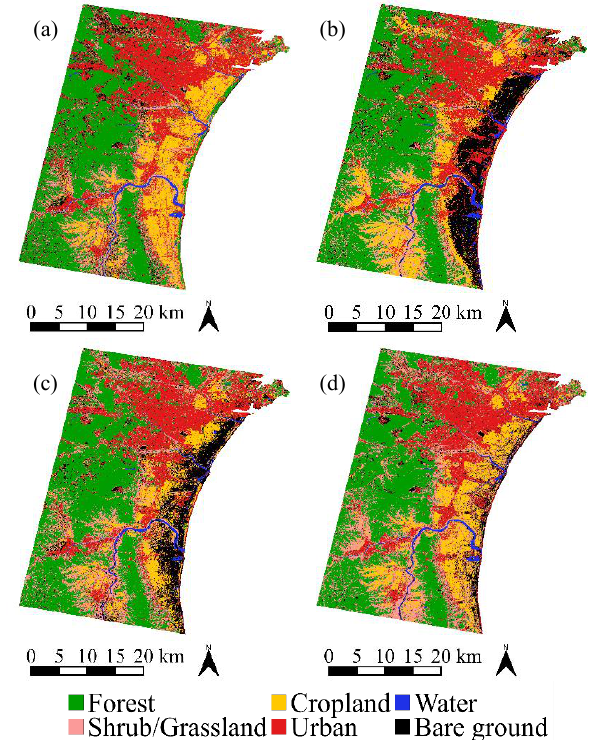
Figure 4. Land cover maps obtained with MCS aggregation: (a) 2010, (b) 2011, (c) 2012, (d) 2016.